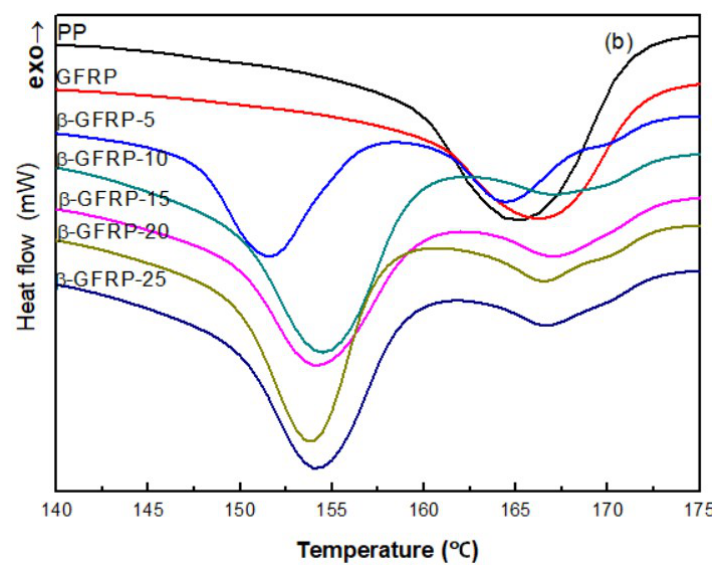
Figure 7. The crystal behavior and melting behavior of β -GFRP composites: ( a ) DSC curves of crystallization behavior; ( b ) DSC curves of melting behavior.